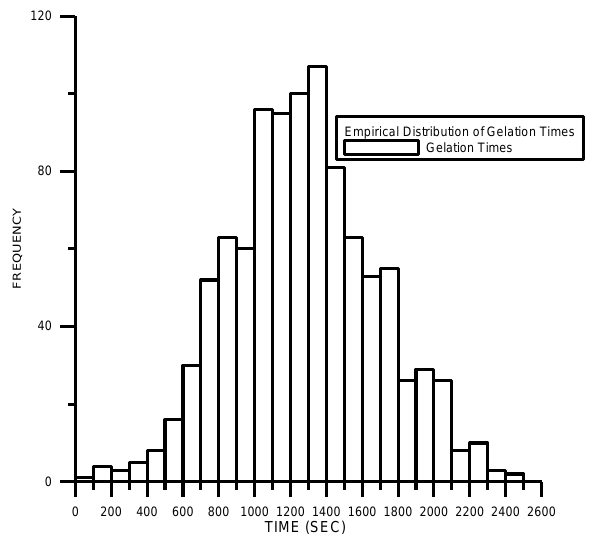
Fig. 9. Empirical distribution for the gelation times obtained for the turbulent case. The results were generated from 1000 realizations of the Monte Carlo algorithm.